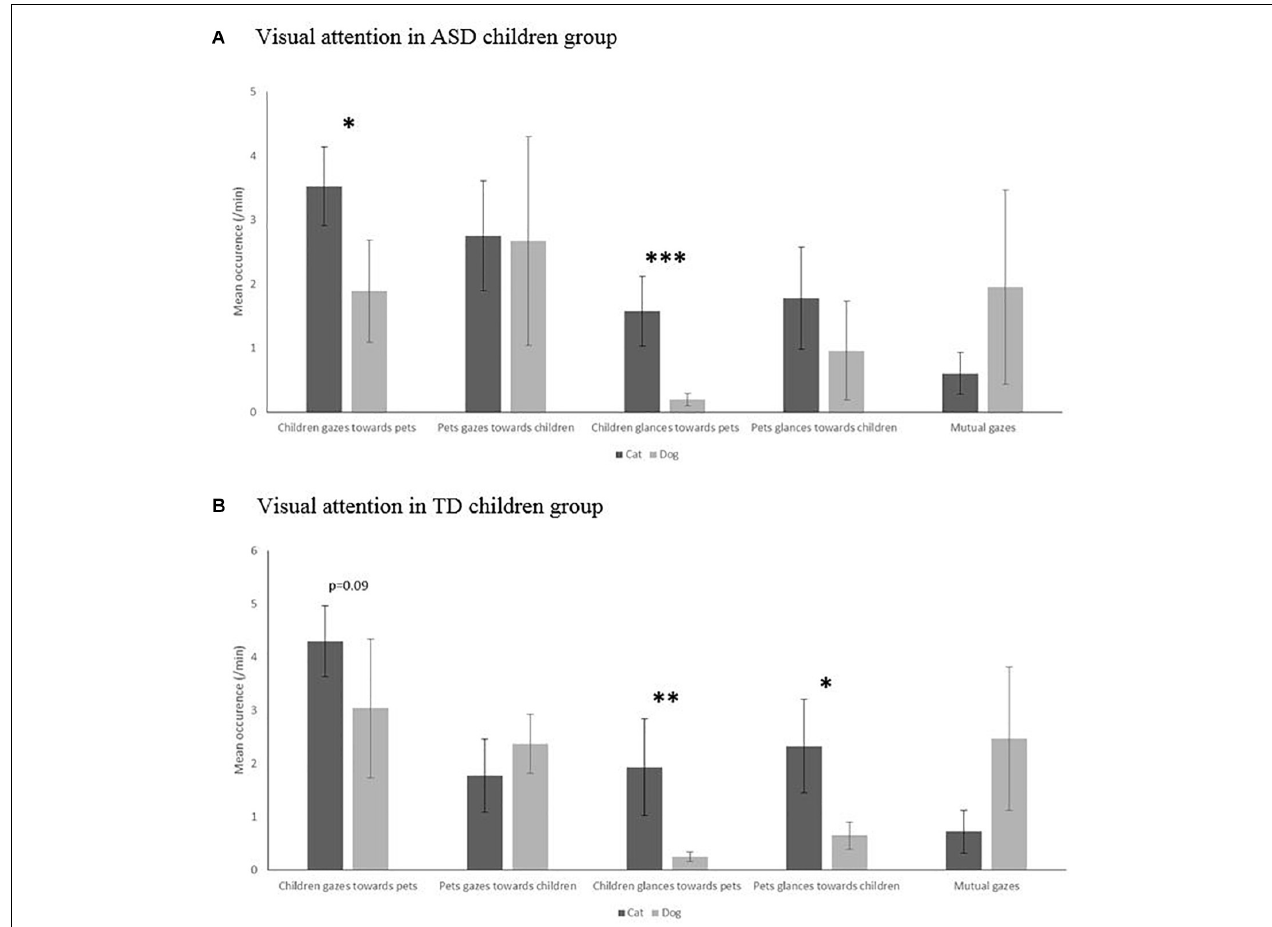
FIGURE 2 | Visual attention in occurrence per minute (glance, gaze, and mutual gaze) in cat–child dyads compared to dog–child dyads in the autism spectrum disorders (ASD) children group (A) and typically developing (TD) children group (B) . Mann–Whitney level of significance: ∗ p < 0.05, ∗∗ p < 0.01, ∗∗∗ p <